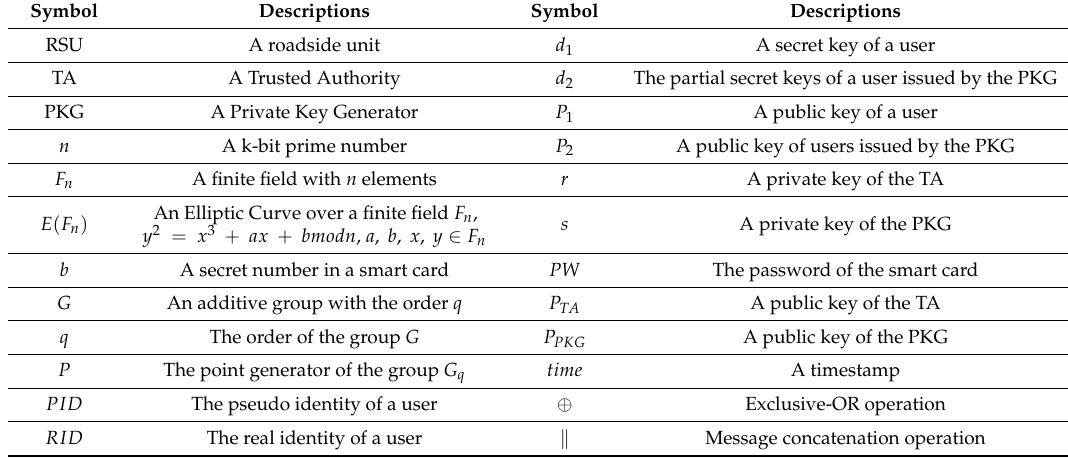
Table 1. List of